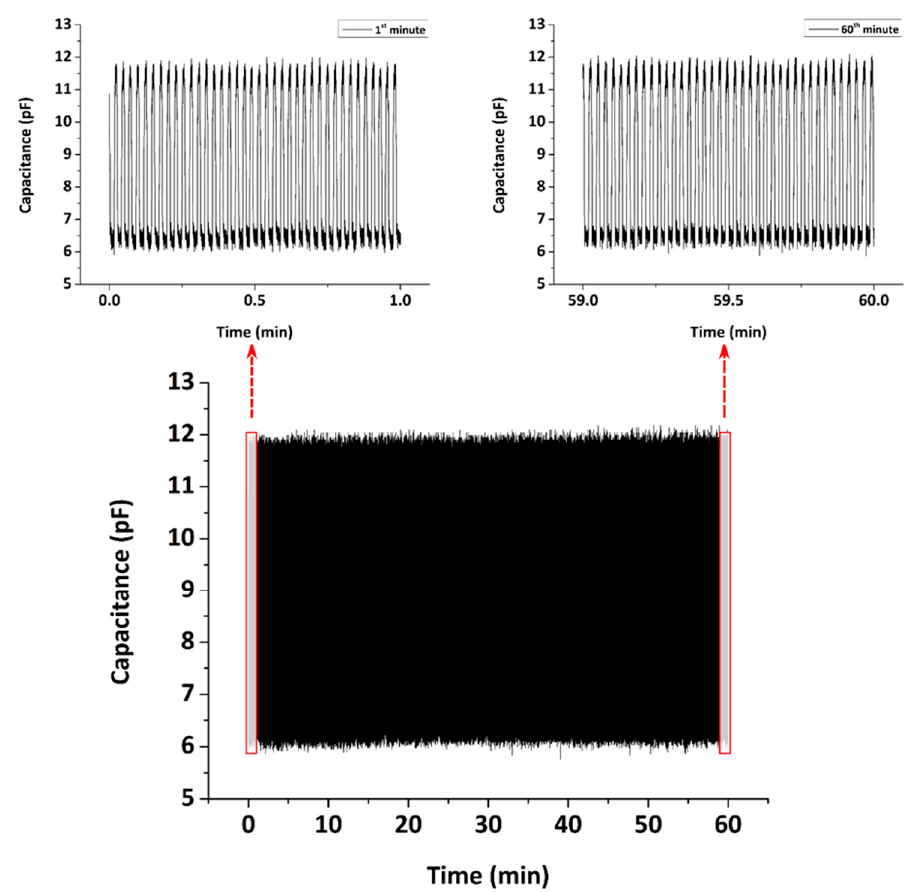
Figure 8. Capacitance response of a typical 3D-printed capacitive pressure sensor during 1 hour of continuous measurements at 40 steps/min gait speed under an applied pressure of 872.4 kPa